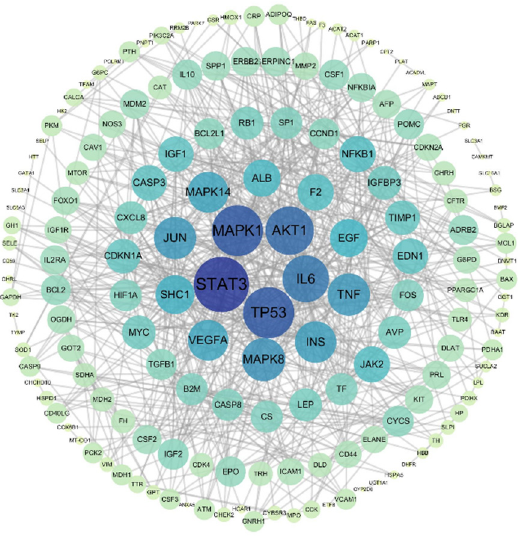
Figure 4. PPI network of common targets between daylily and lactation.